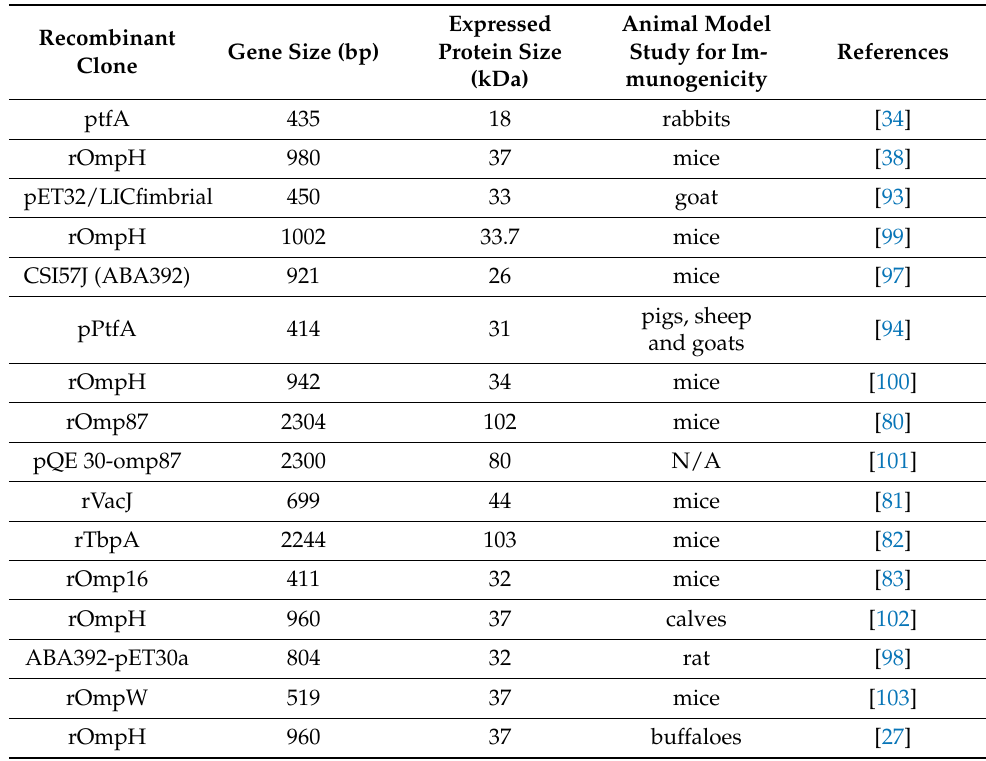
Table 1. The potential recombinant subunit candidate vaccine against